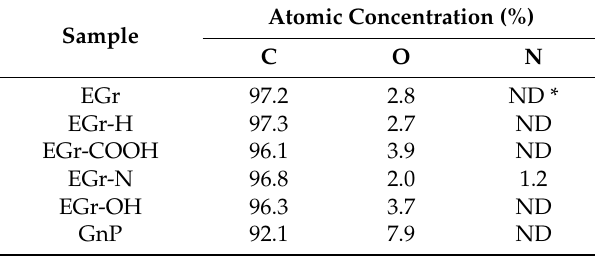
Table 1. Atomic concentration of elements on the surface determined by X-ray photoelectron spectroscopy (XPS) for the materials studied.